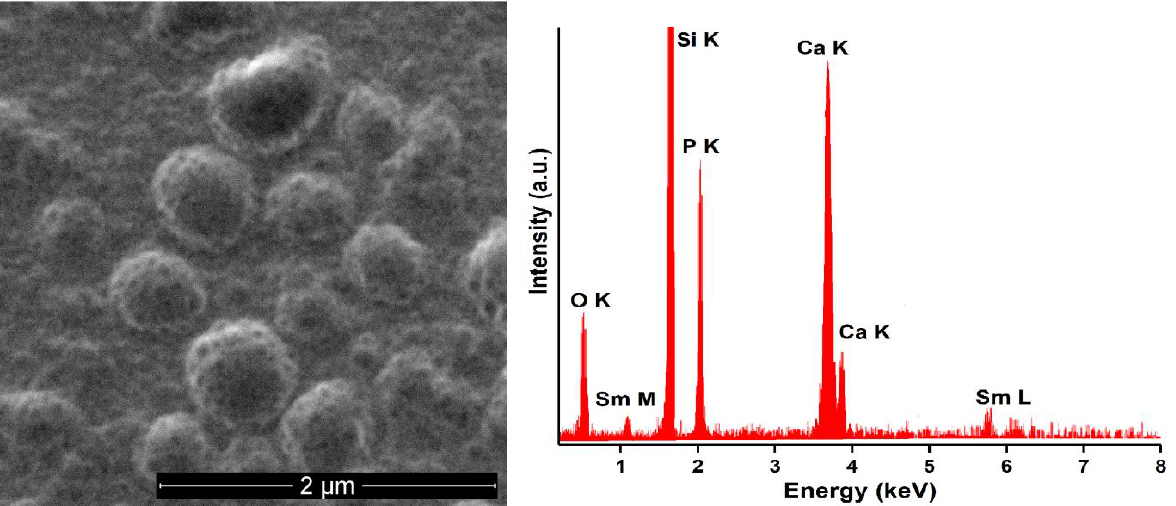
Figure 4. SEM micrograph ( left ) and EDX spectra ( right ) obtained on 10SmHAp deposited in Si substrate.